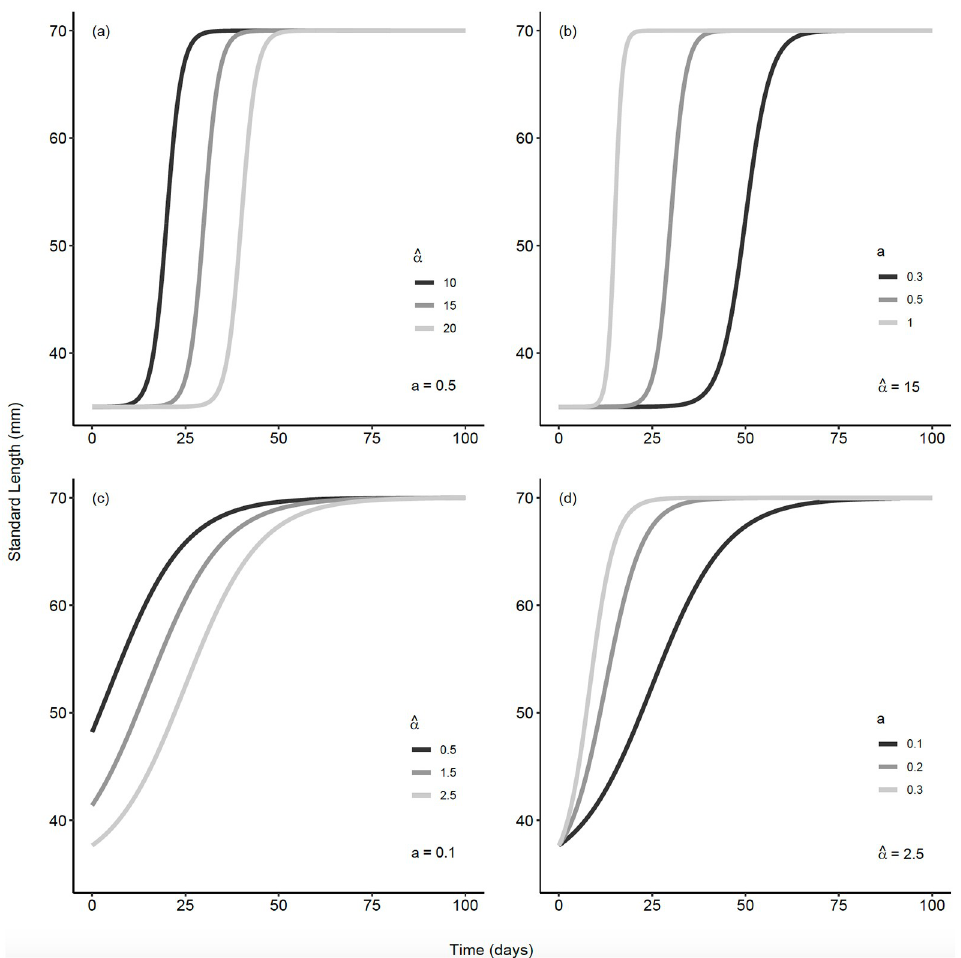
Fig 2. Growth curves generated from Eq 1. over a 100 day growing period. A: Effect of ^ a on the timing of the inflection point. B: Effect of a on the slope of the growth curve. Panels C and D: Growth curves for values of the two parameters that are closer to those estimated from our data. For the curves in C in particular, the inflection point occurs close to time t = 0, so that the intercepts vary between parameter values. In these cases, fish are close to the lower bound on the curve Y 0 when time is less than zero, which is to say, before sampling begins. In all panels Y 0 = Y 1 = 35.